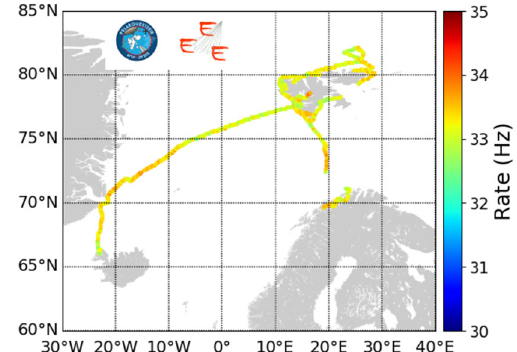
Fig. 25 Rateofcosmicparticles,correctedforalltheeffectsmentioned in the previous Section, measured by POLA-01 during its trip in the Arctic Sea